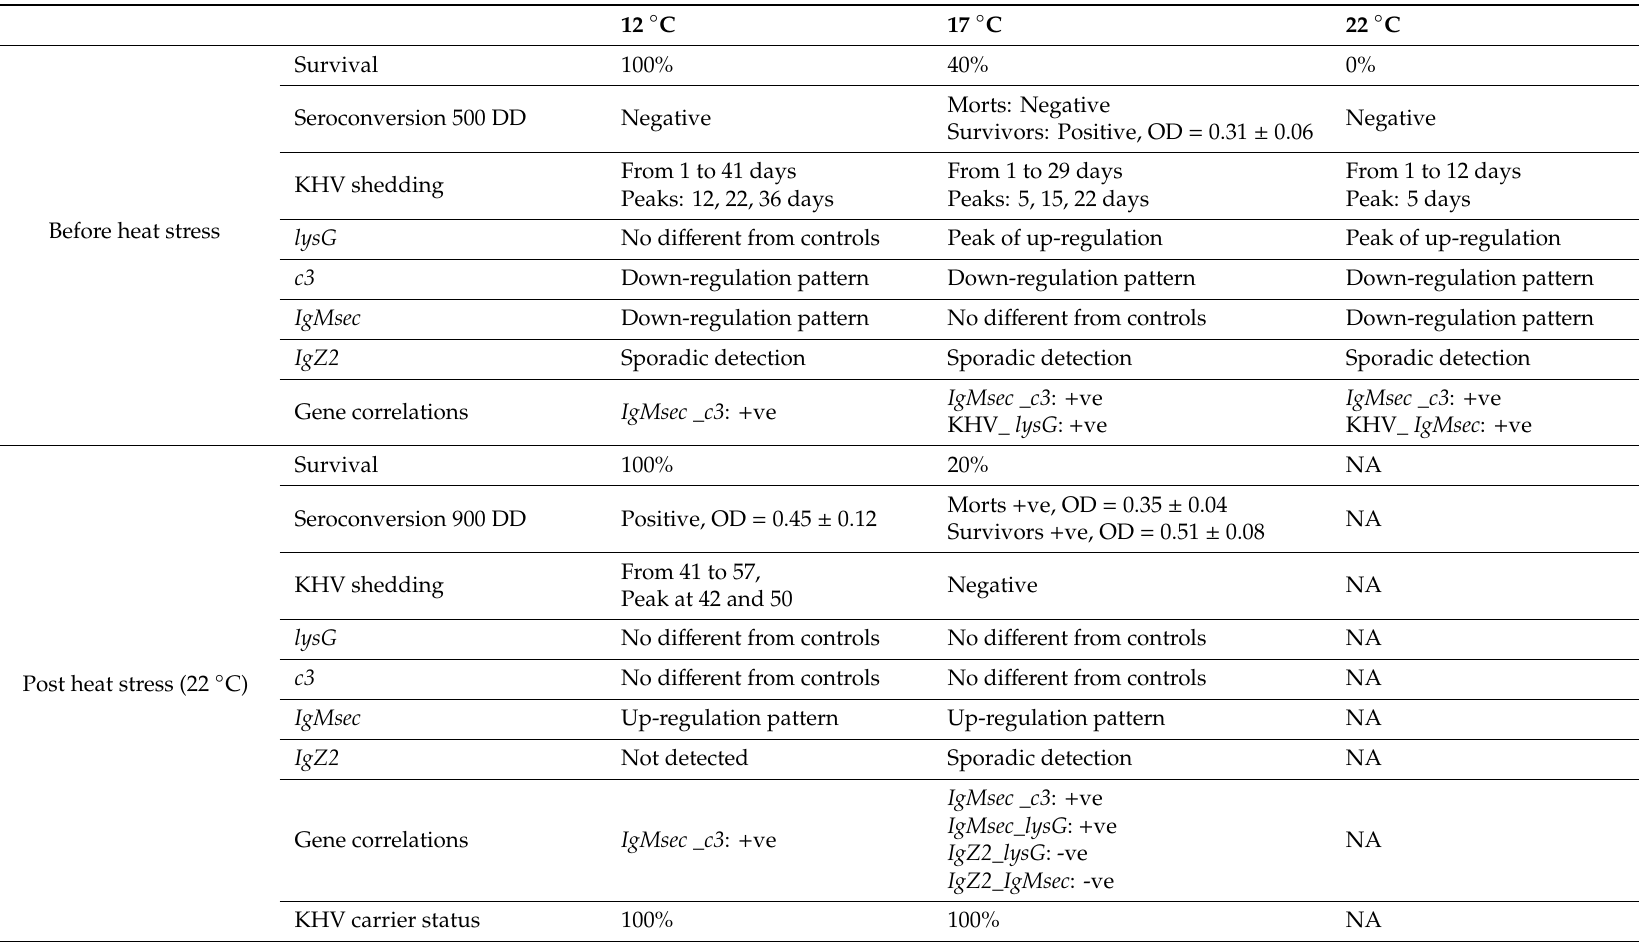
Table 1. Table showing summary results for common carp exposed to KHV either non-permissive (12 ◦ C) or permissive temperatures (17 and 22 ◦ C). For each temperature treatment before and after heat stress (temperature increase to 22 ◦ C); survival rates; seroconversion at 500 and 900 degree days; the window of KHV shedding; the gene expression patterns of lysozyme g ( lysG ), complement c3-h1 ( c3 ), immunoglobulin M heavy chain secretory protein ( IgMsec ), immunoglobulin Z2 heavy chain ( IgZ2 ); and pairwise correlations among them are shown. + ve: positive; -ve: negative; OD: ELISA test optical density; NA: not